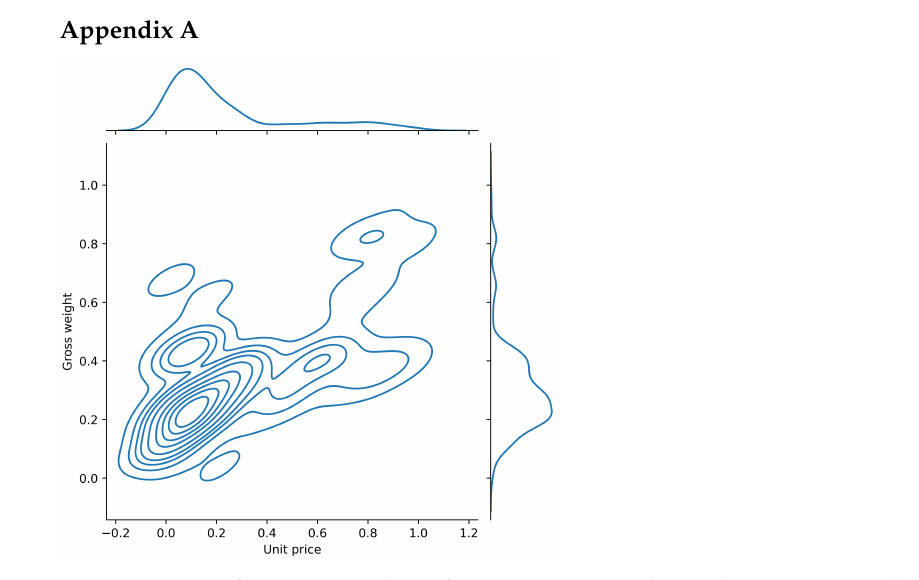
Figure A1. Two of the most correlated features, “gross weight” and “unit price”, with bivariate and univariate graphs.